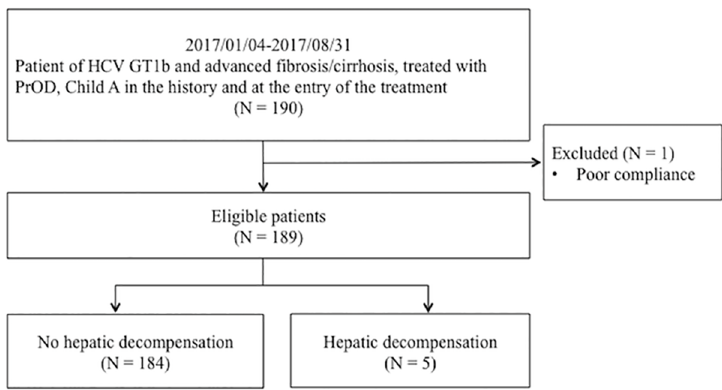
Fig 1. The selection of patients included in the study. HCV GT1b = hepatitis C virus genotype 1b, PrOD = paritaprevir/ritonavir/ombitasvir plus